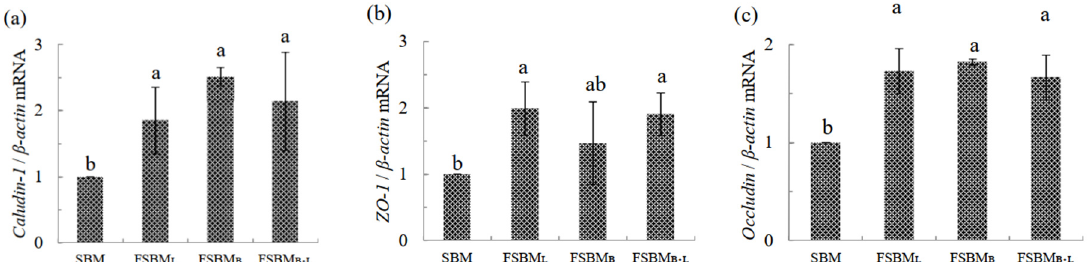
Figure 4. Effect of two-stage FSBM on jejunum’ s relative mRNA expression of genes related to Caludin-1 ( a ), ZO-1 ( b ), and Occludin ( c ) of 35 day-old broilers. Each value represents the mean ± standard deviation (n = 5). a, b Means within a row with different letters differed significantly ( p < 0.05). SBM: Soybean meal; FSBM L : commercial control; FSBM B : SBM one-stage fermented by Bv; FSBM B+L : SBM two-stage fermented by Bv and Lb.